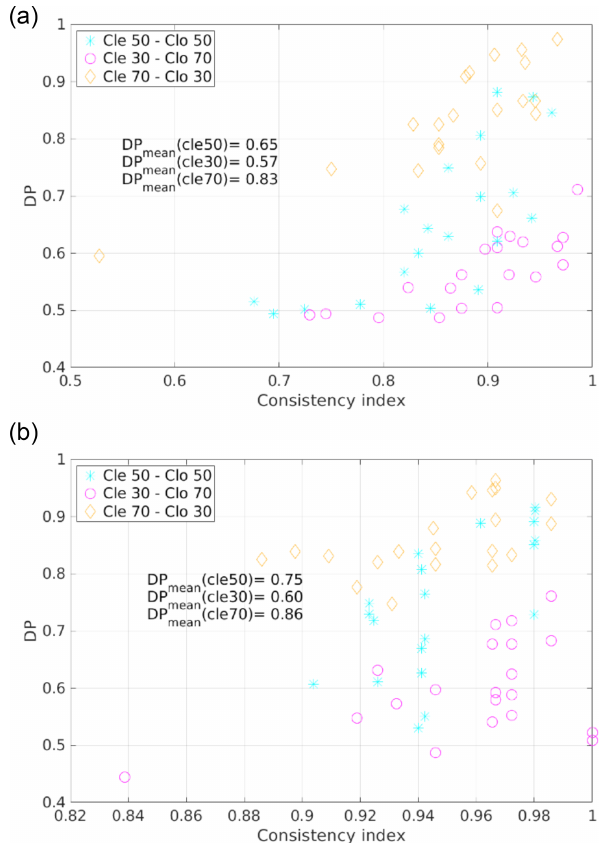
Figure 10. Scatterplot of DP and CoI for multiple training sets (grouped into the three TraNC reported in the legend). Results are shown when using both the elementary approach (a) and the distri- butional approach (b) . For each group an average value of the DP is computed and reported in the plot.